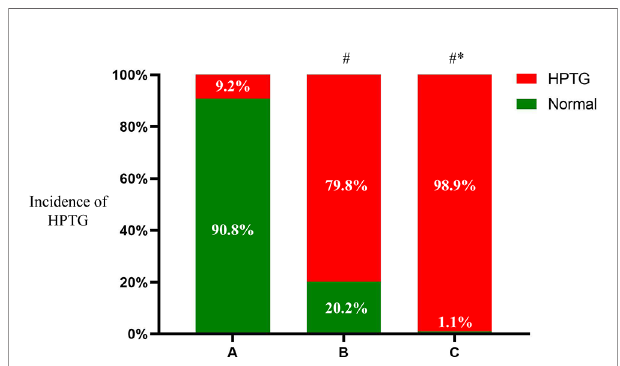
FIGURE 2 | Incidence of HPTG in groups with different FTG concentrations. Incidence of postprandial hypertriglyceridemia were analyzed to evaluate differences among groups with different fasting triglycerides concentrations. All data are expressed as percentage. # P < 0.05 vs. group A. *P < 0.05